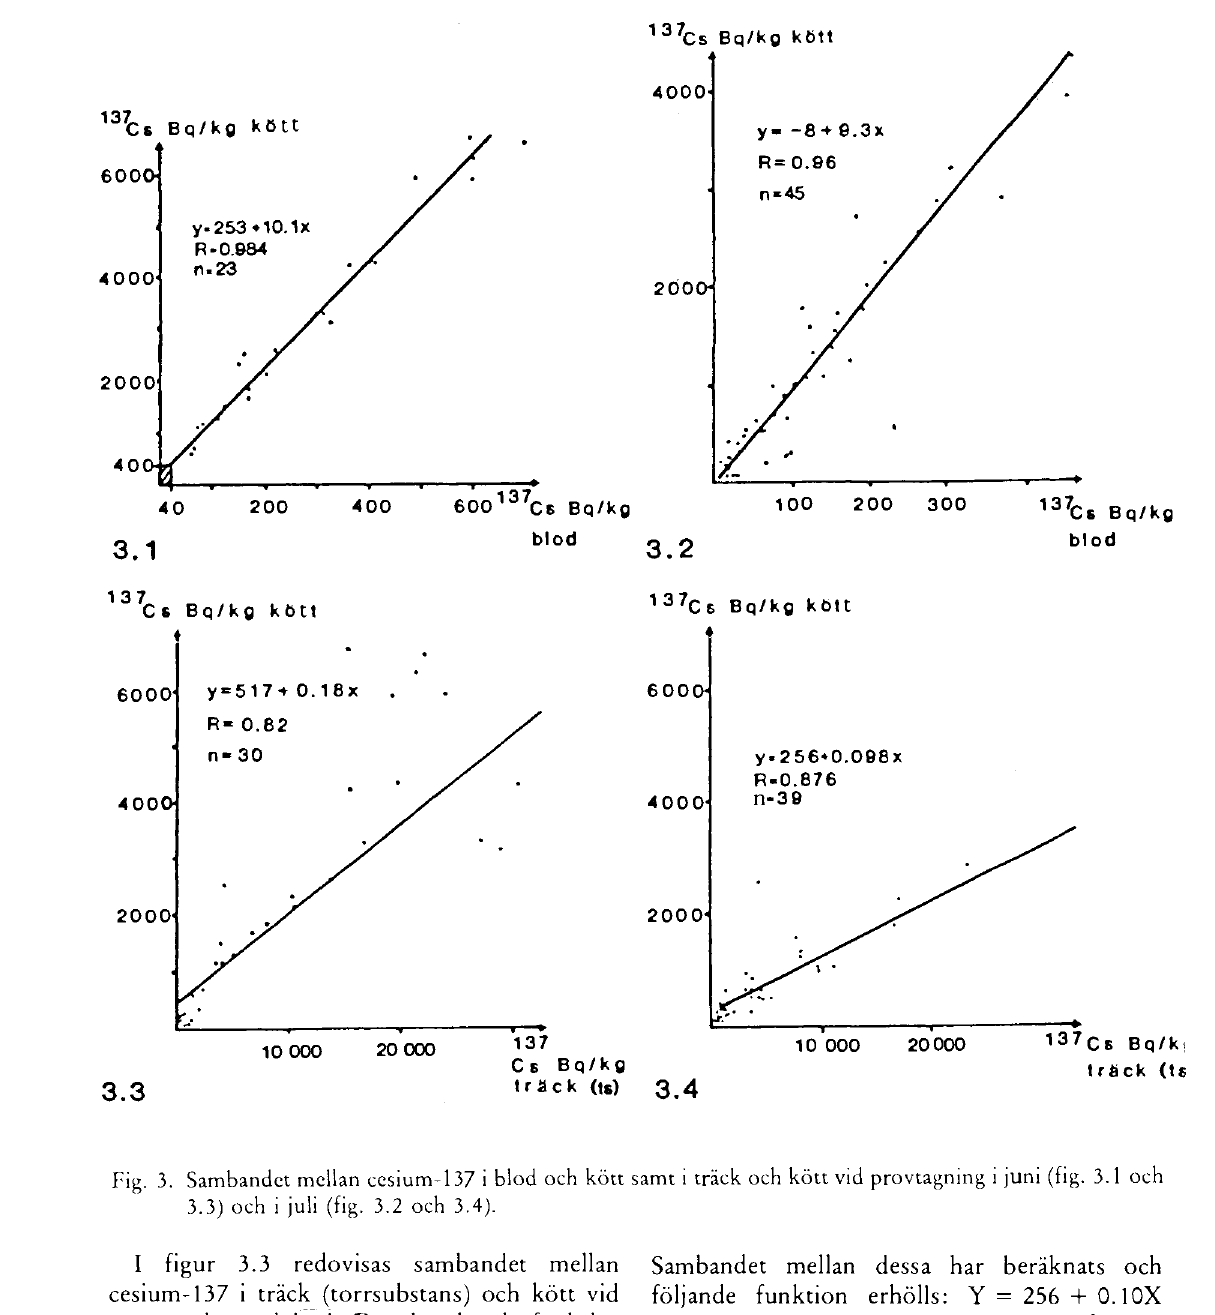
I figur 3.3 redovisas sambandet mellan cesium-137 i track (torrsubstans) och kott vid provtagningen i juni. Den beråknade funktio¬ nen, Y = 517 + 0.18X (N = 30), har betydligt lagre korrelationskoefficient (R = 0.82) ån motsvarande funktion for blod och kott. Skillnaden torde bero på att tråeken, i mycket hogre grad ån blodet, foljer variationerna i intag av cesium dagarna nårmast fore provtagning. Från provtagning i juli finns cesiumhalter i track och kott fran 39 renar (figur